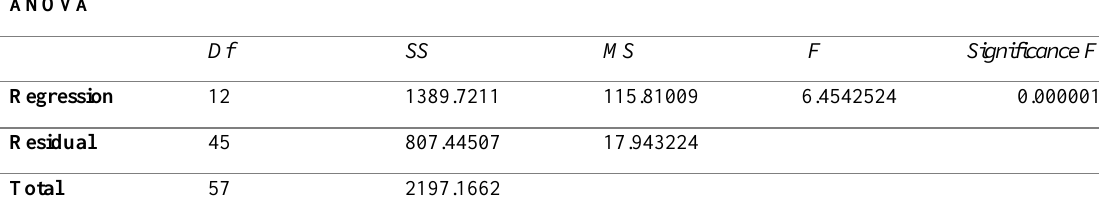
Table 23: ANOVA (Rangpur Division)